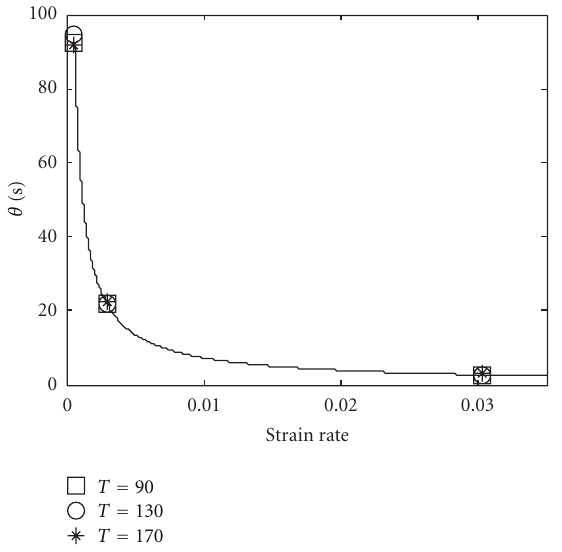
Figure 5: Relations between relaxation time θ and strain rate.